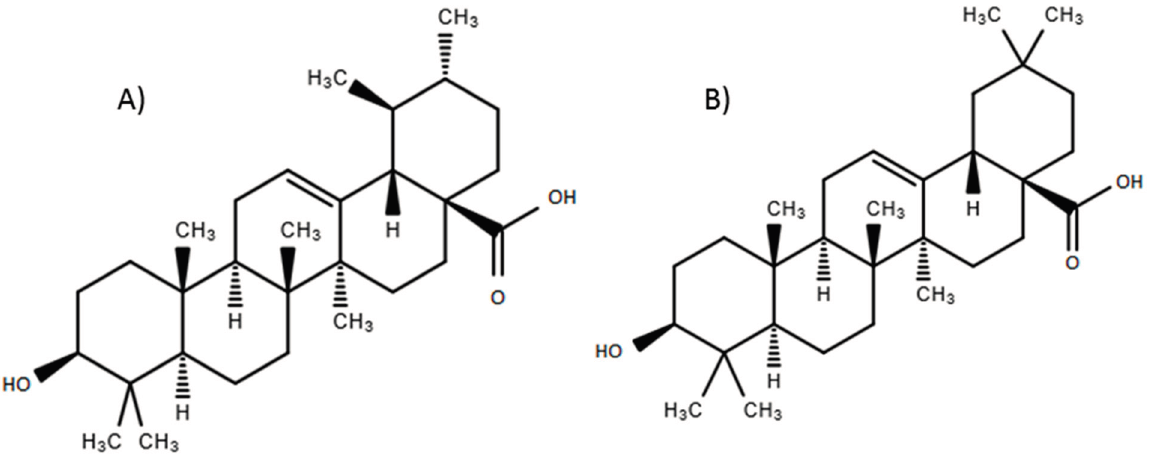
Figure 1. Chemical structure of ursolic ( A ) and oleanolic ( B )